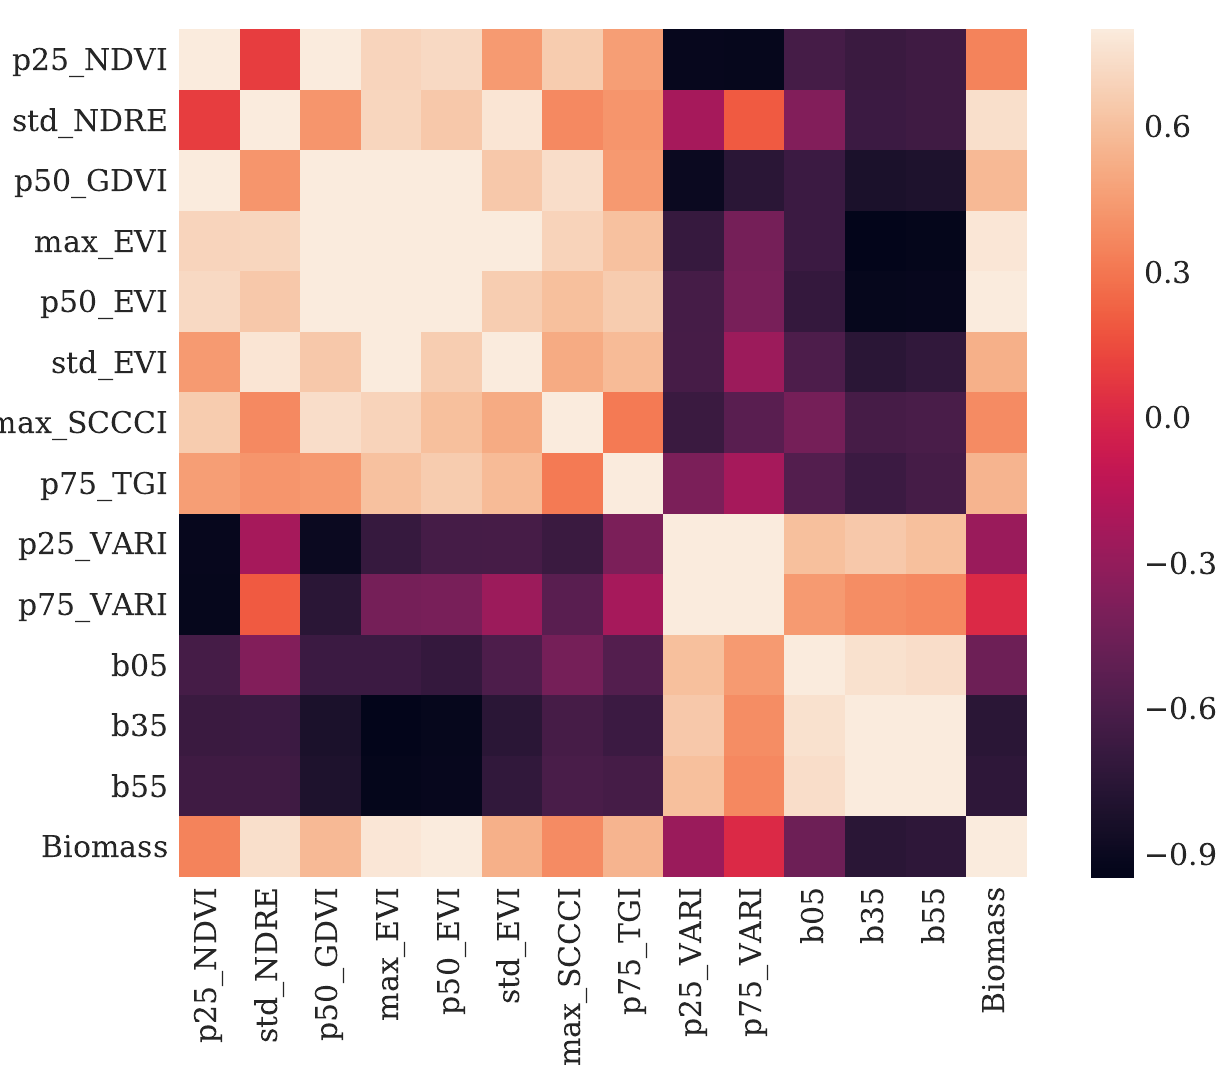
Figure 7. Correlation matrix between selected features and biomass in Period